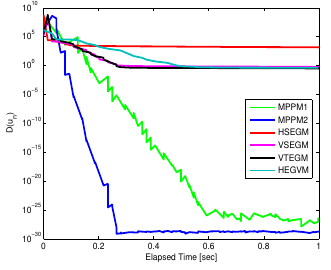
Figure 2. Methods for Example 1 with α n = ( n + 1) − 0 . 9 . Number of iterations is 81, 94, 159, 254, 341, 390, respectively.